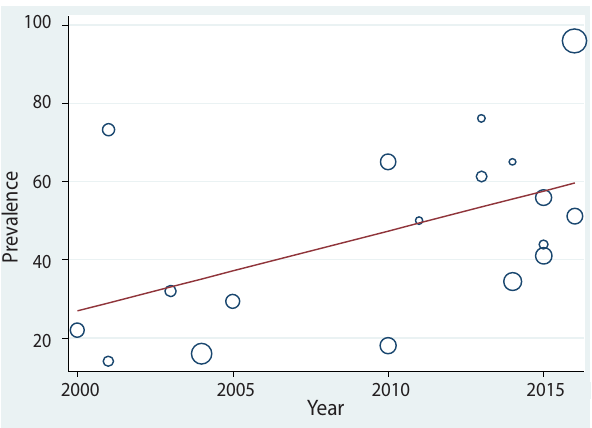
Figure 3 . Prevalence of depression among Iranian breast cancer, showing an increase in prevalence from 2000 to 2018